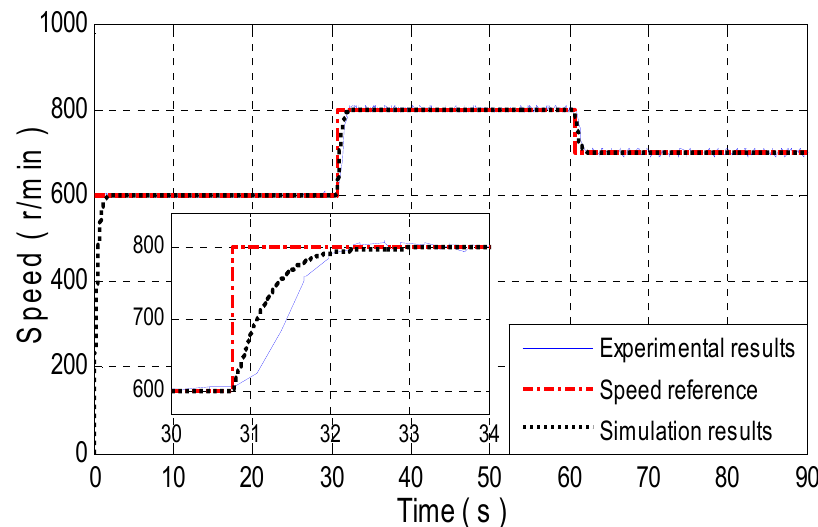
Figure 20. Speed profile and its reference, with zoom.